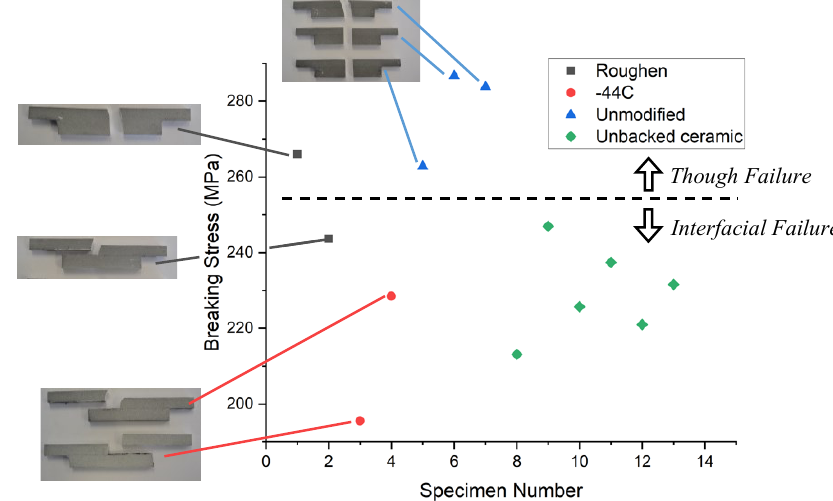
Fig. 6 . Ceramic breaking stress calculated from simple beam theory for different surface preparations. Compared to the unbacked ceramic specimens (green diamond ), there is a clear increase in breaking stress as long as the polymer stays adhered to the